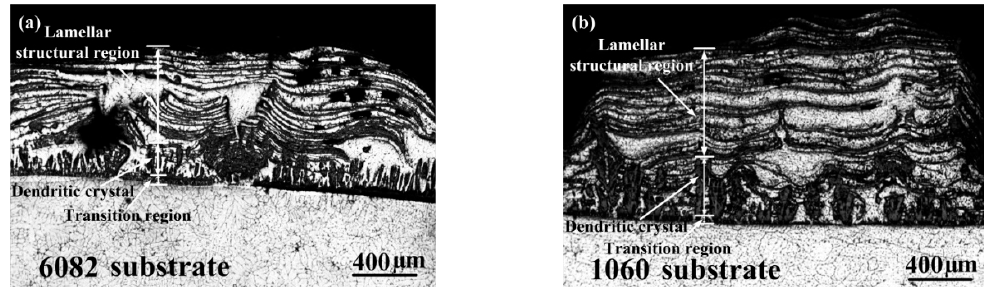
Figure 3. Optical microscopy (OM) photographs of perpendicular sections from ( a ) AlN-6082 and ( b ) AlN-1060.